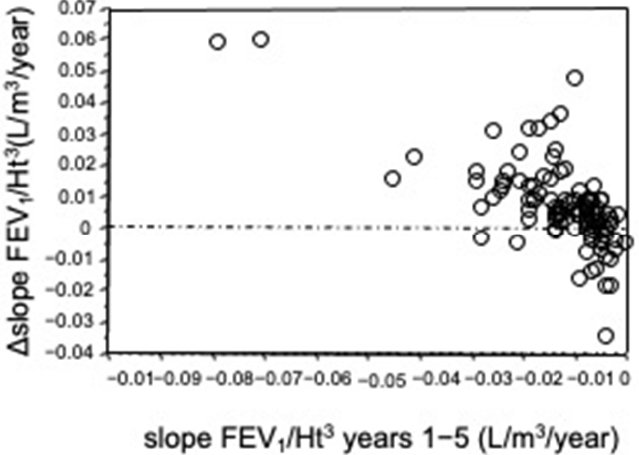
Figure 2. Relationship between the individual differences between the slope of the 6th–10th year period and slope of the 1st–5th year period ( ∆ slope FEV 1 /Ht 3 ) and slope FEV 1 years 1–5. A significant inverse correlation was found ( p < 0.0001, Spearman Rank Correlation).